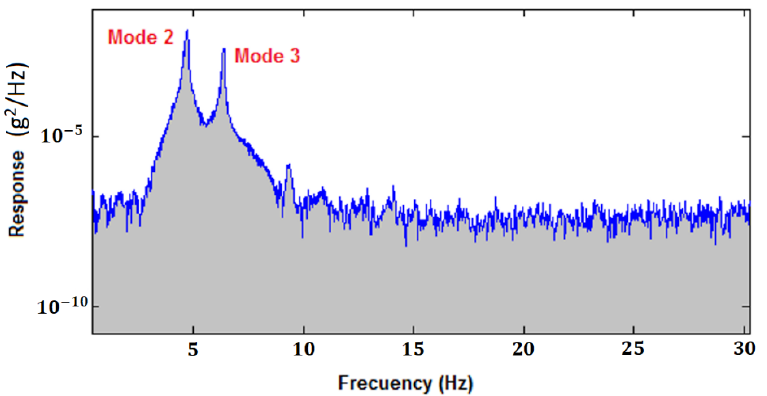
Figure 10. Medium spectrum of the frame response in the frequency domain for bolted joints.